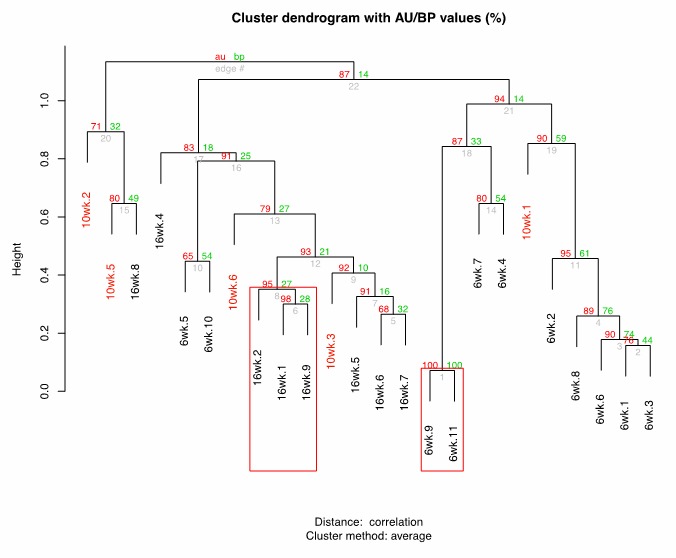
Cluster dendrogram between 6wk-10wk-16wk wild-type killifish gut microbiota.